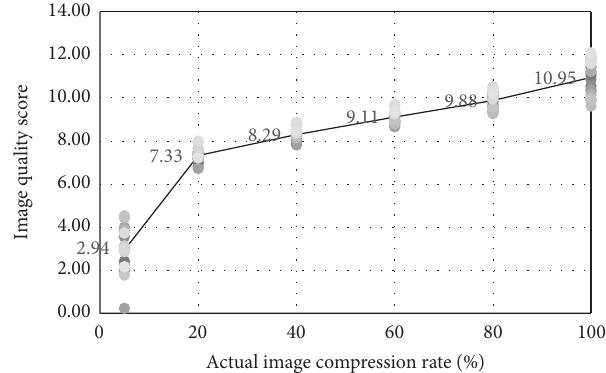
Figure 9: Image quality score in different noise